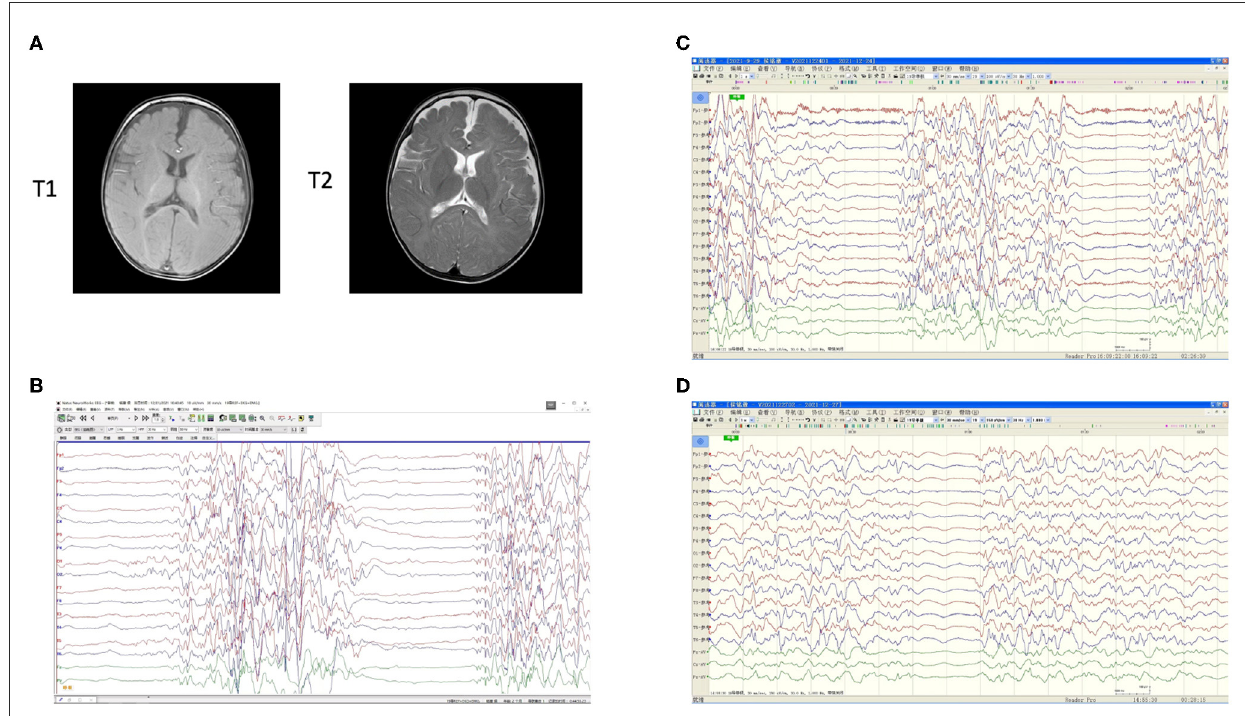
FIGURE1 Imaging examinations of the patient. Brain magnetic resonance imaging (MRI) showed no obvious abnormality at the age of 6.5 months (A) . T1-weighted and T2-weighted images were consistent. Electroencephalogram (EEG) results before and after antiepileptic medications (B – D) . (B) A burst-inhibition pattern was observed before any medication at 2 months. (C) With a treatment of oral adrenocorticotropic hormone (ACTH), topiramate, and valproic acid, the intensity of the burst period was significantly weakened, but the burst-inhibition pattern was still obvious, and their durations remained relatively long. In addition, a small amount of bilateral discharge and an extremely asymmetric background were observed. (D) After treatment of prednisone, topiramate, levetiracetam, and midazolam, there were very few burst periods and reduced inhibition periods, with significantly shorter durations at 3 months. A small amount of 4–6c/s θ activity was visible and distributed. Distinguishable focal discharges in the background, apparent asymmetry, and a tendency for a high degree of arrhythmia were also